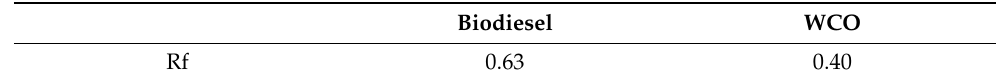
Table 5. Rf values were obtained